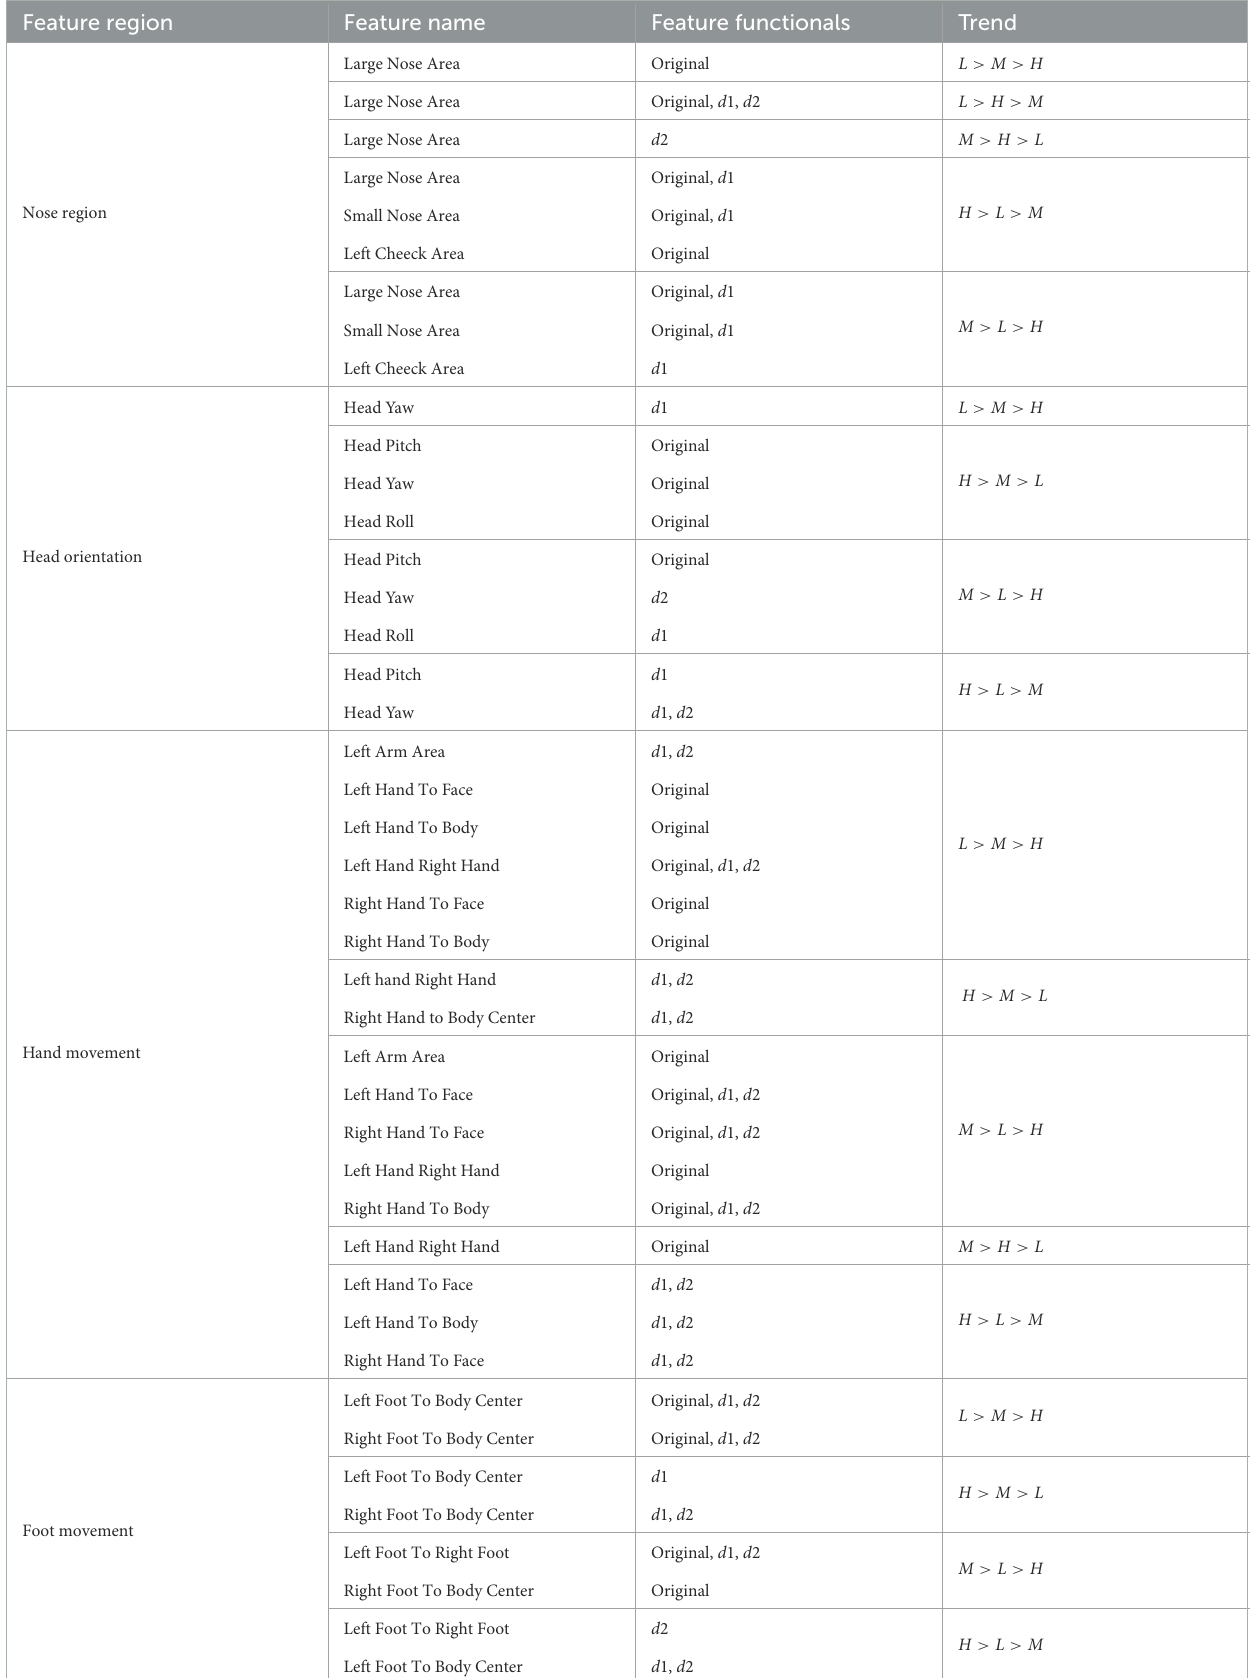
TABLE 5 Summary of significantly different feature functionals among three